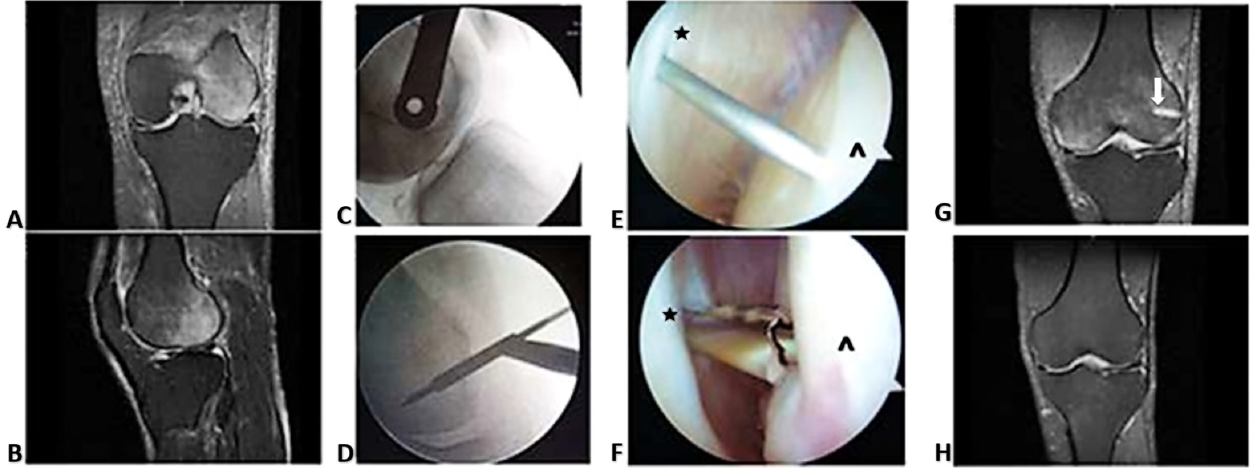
Figure 2. Migratory BME. ( A ) Coronal and ( B ) sagittal sections display high signal intensity in the lateral femoral condyle on the MRI T2 FS sequence. ( C ) Lateral and ( D ) AP X-ray views show fluoro- scopic guidance of guide pin placement. ( E , F ) Arthroscopic guidance of pin and 4 mm cannulated drill tip through the joint capsule (*) to the femoral condyle (^). ( G ) BME observed in the medial femoral condyle on the coronal MRI T2 FS sequence. The previous decompression track is visible (arrow). ( H ) Coronal MRI T2 FS sequence showing resolution of high signal intensity in both con- dyles and healing of decompression tracks.